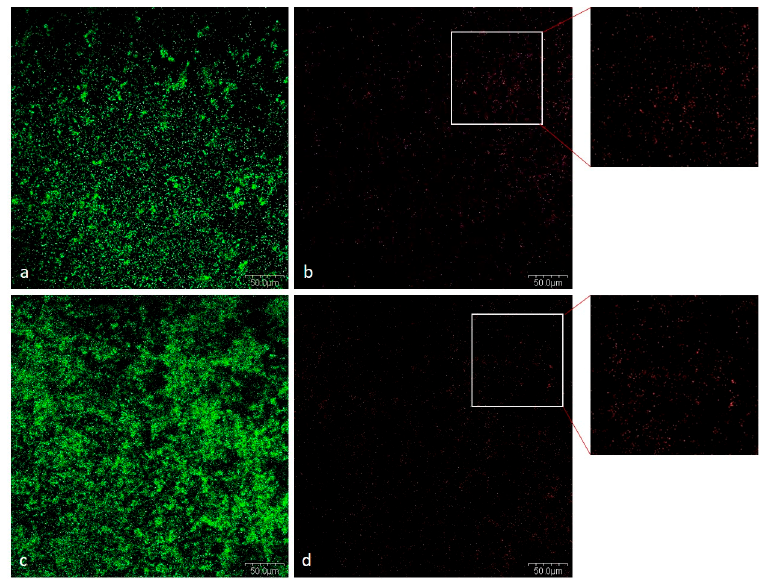
Figure 6. Illustration of dead (red) and live bacterial cells (green); ( a ) SYTO-9 stain in salivarius mixed biofilm; ( b ) Propidium iodide in salivarius mixed biofilm ( c ) SYTO-9 in non-salivarius mixed biofilm; ( d ) Propidium iodide in non-salivarius mixed biofilm; Magnification 20 × .